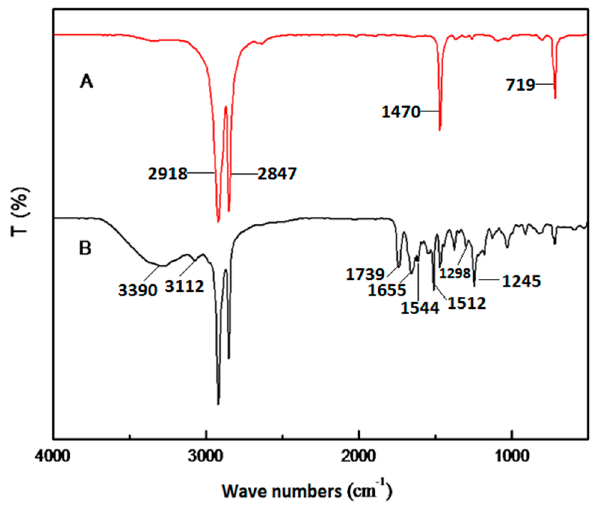
Figure 3. FT-IR spectra of ethylene homopolymer ( A , run 1 in Table 1) and ethylene/ N - acetyl- O -(but-3-enyl)- L -tyrosine ethyl ester copolymer ( B , run 3 in Table 1. Copolymerization of ethylene and N -acetyl- O -( ω -alkenyl)- L -tyrosine ethyl esters with titanium complex.